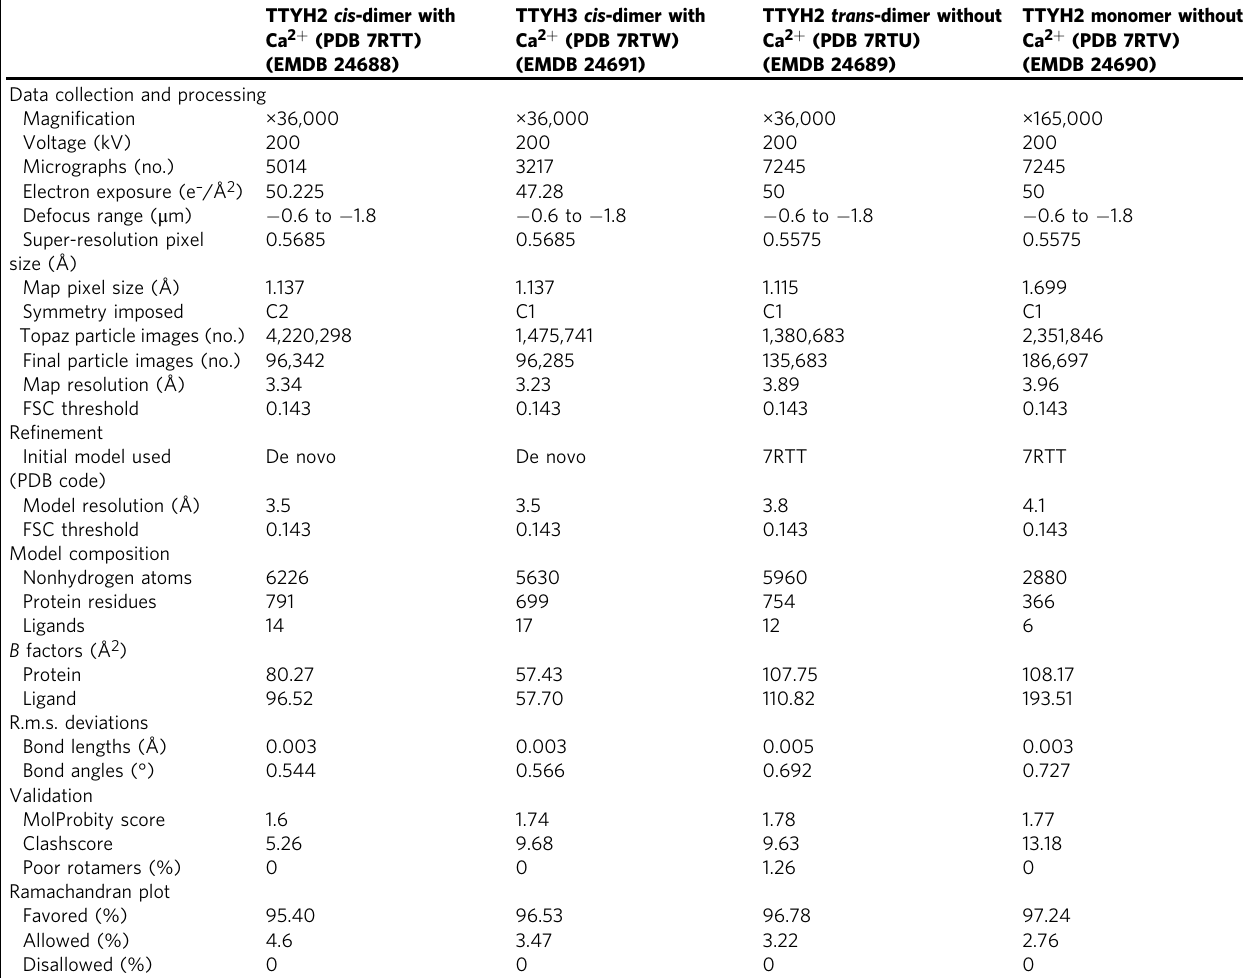
Table 1 Cryo-EM data collection, re fi nement, and validation